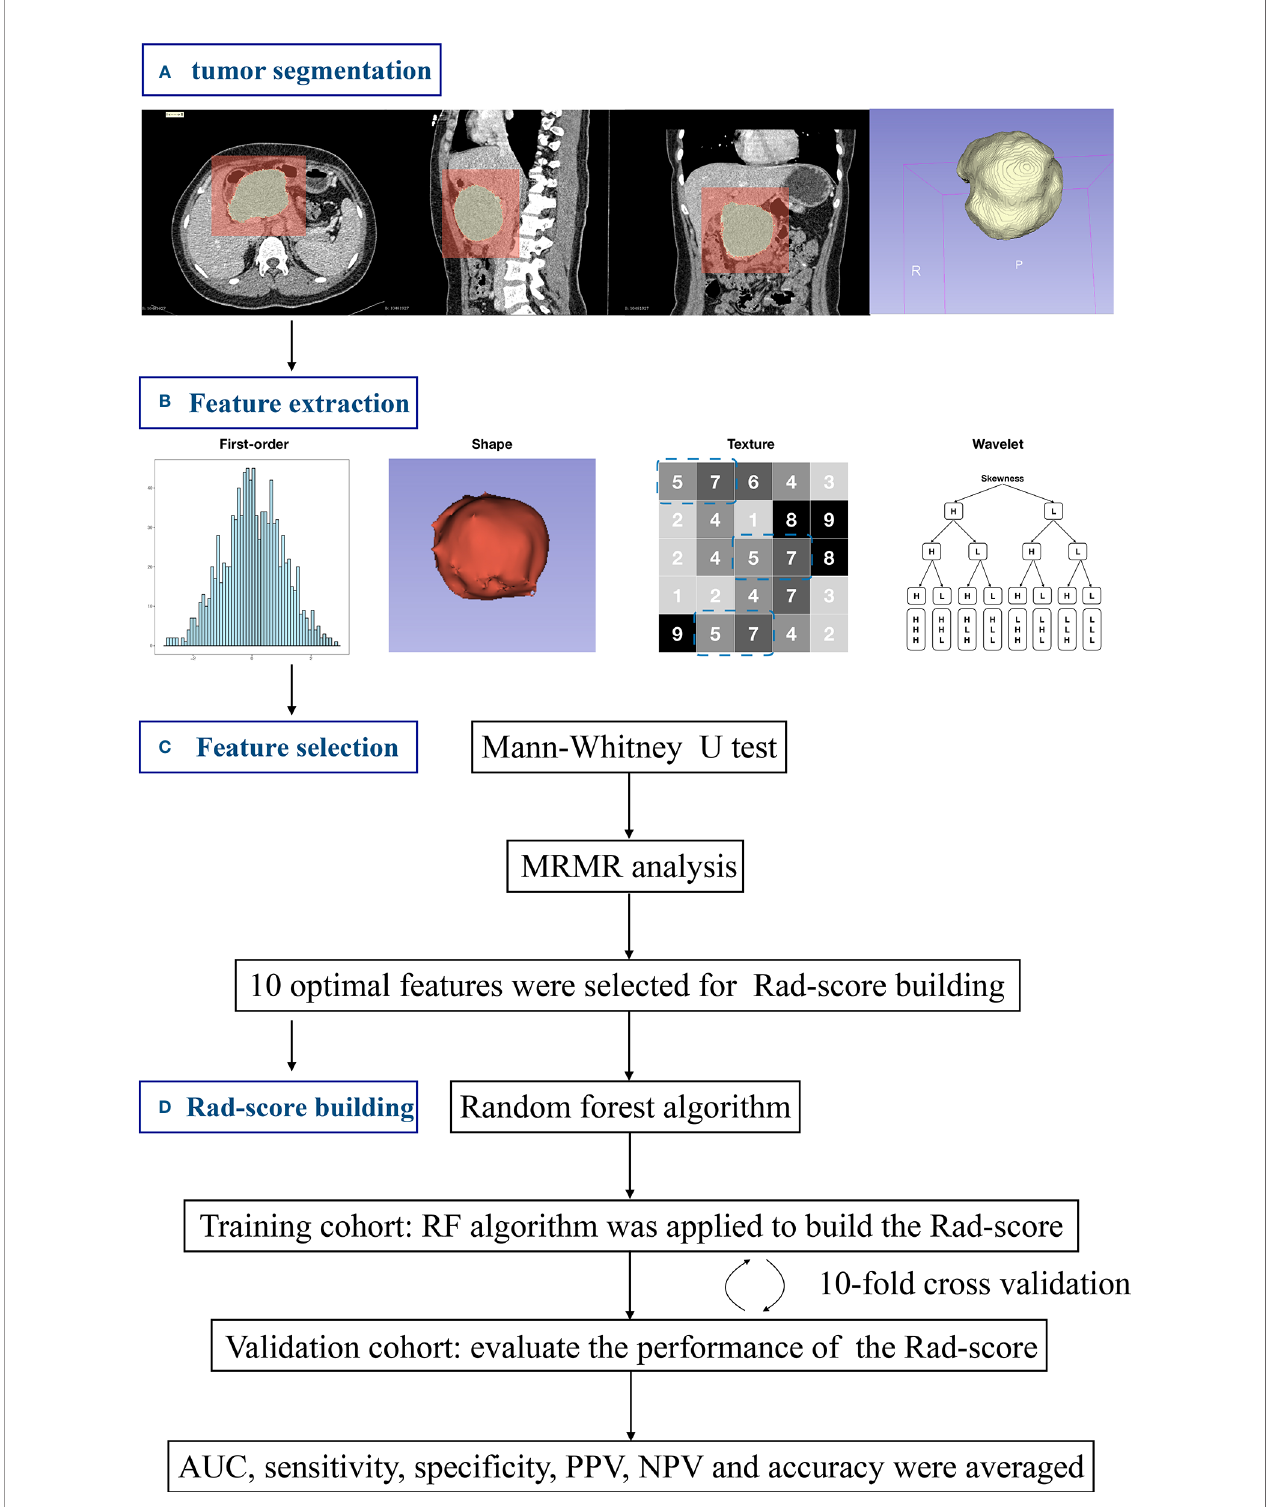
FIGURE 1 | Work fl ow of the radiomics analysis. (A) Tumors were semi-manually segmented on all slices. (B) Radiomics features were extracted. (C) Feature selection procedure was used to identity the optimal feature set. (D) The Rad-score was built using random forest method and validated by 10-fold cross validation.